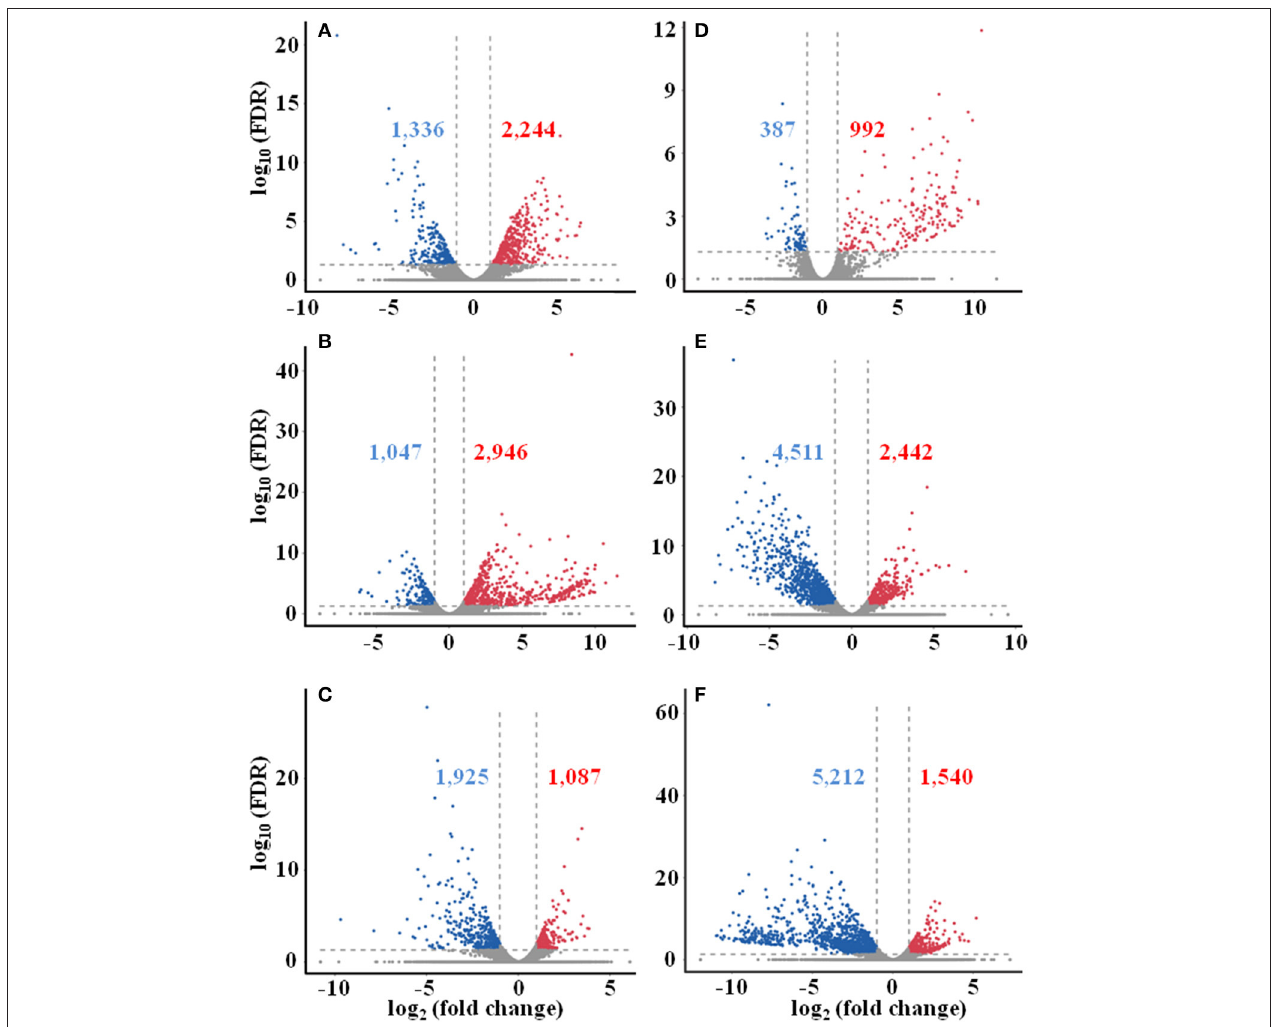
FIGURE 4 | Distribution of differentially expressed unigenes in different seasonal FD-TRs in T. hemsleyanum using Volcano plot. (A) Su vs. Sp, (B) Au vs. Sp, (C) Wi vs. Sp, (D) Au vs. Su, (E) Wi vs. Su, and (F) Wi vs. Au. Red numbers and dots represent upregulated unigenes, blue number and dots represent downregulated unigenes, and gray dots represent unigenes with no change between comparing pairs. Sp, spring; Su, summer; Au, autumn; Wi, winter.